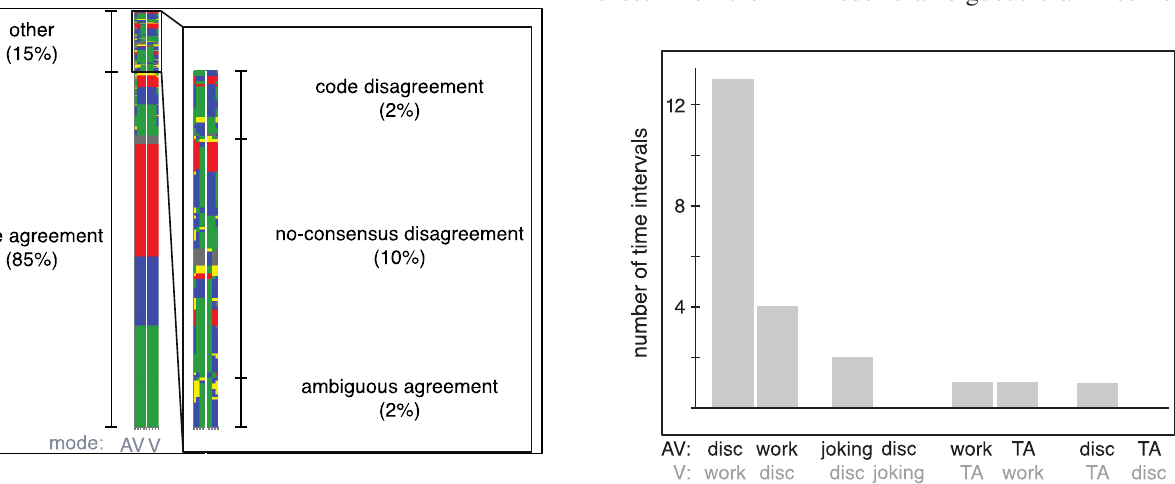
FIG. 1. Intermode reliability. This figure contains the codes, represented by the colors from Table I, for all 886 time segments in the study. Audiovisual (AV) coding is represented in the four columns on the left and visual-only (V) coding in the four columns on the right. Agreement constitutes 87% of time intervals. Explanations of intermode agreement are shown in Table II. The time intervals in this figure are not presented in chronological order; instead, they are reordered and grouped according to agreement type.